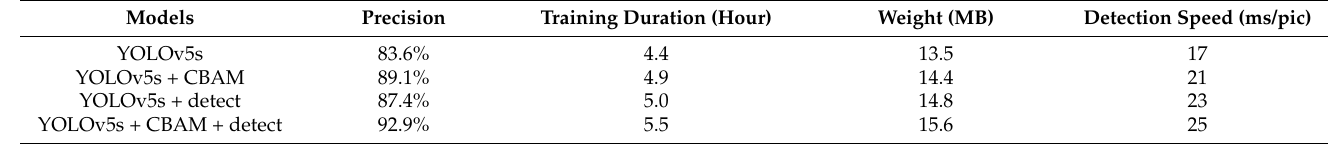
Table 1. Improved YOLOv5s model compared to YOLOv5s, YOLOv5 + CBAM, and YOLOv5s + detect.